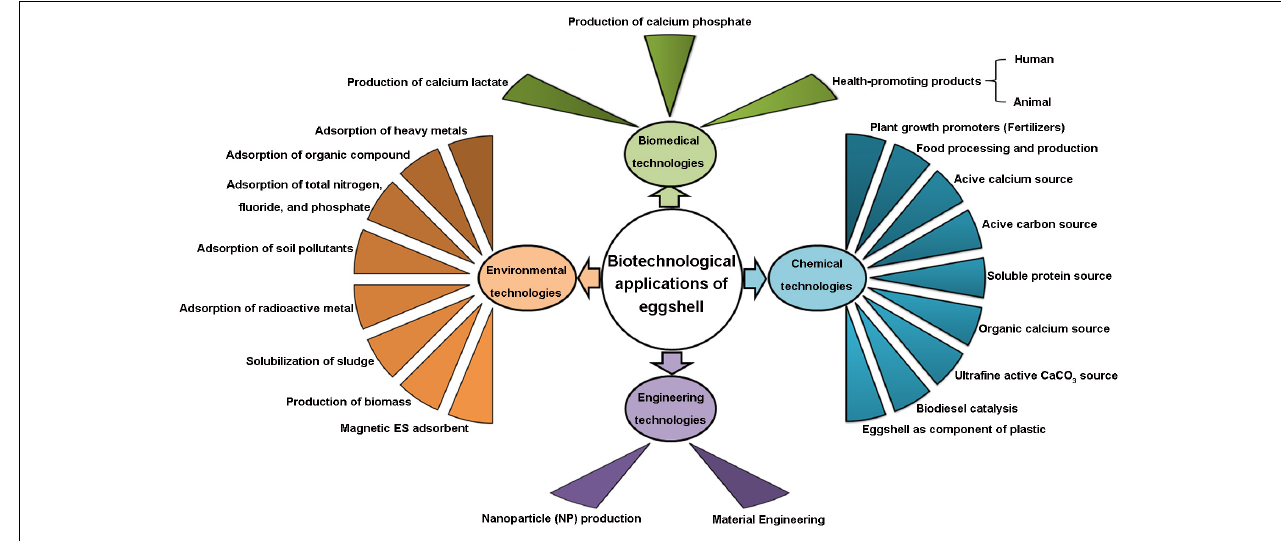
FIGURE 9 | Schematic overview of biotechnological applications of